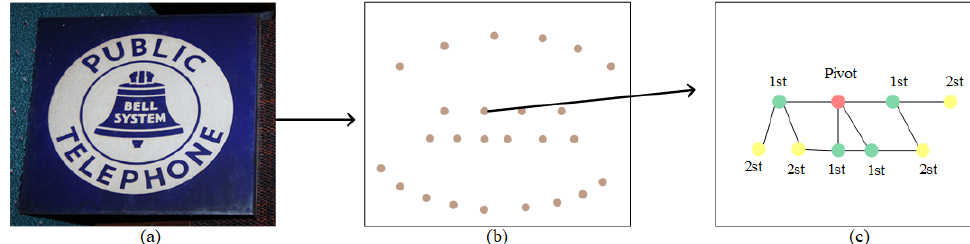
Figure 5. Local inference graph generation. ( a ) Source image. ( b ) Graph of text component nodes. ( c ) Local inference graph. “1st” indicates the first-order nodes and “2st” denotes the second- order